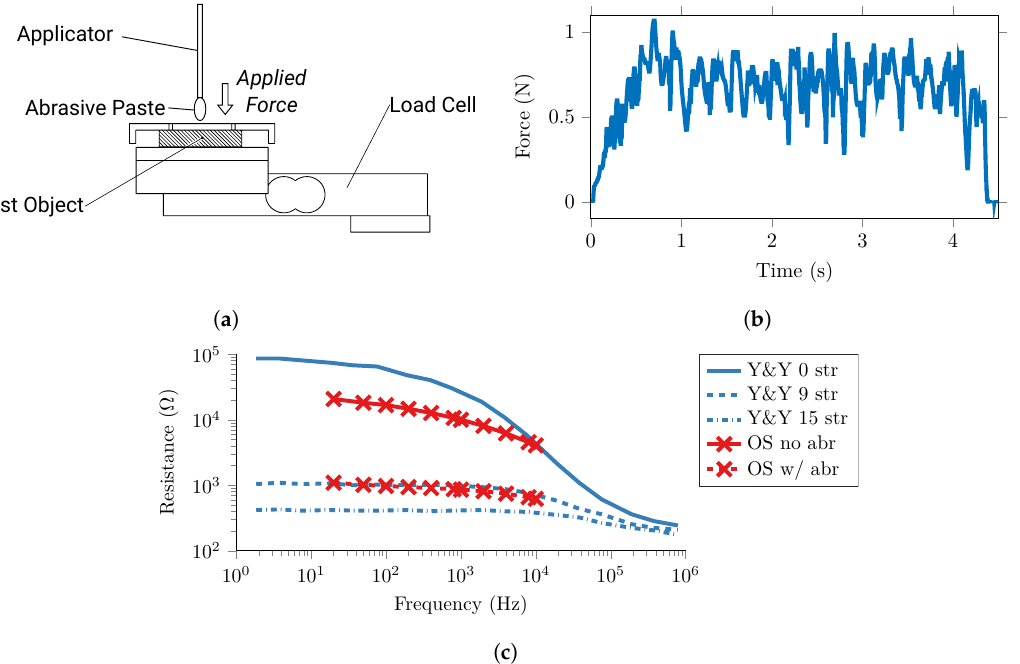
Figure 5. Characterisation of conventional manual abrasion via applicator and abrasive paste ( a ) experimental setup ( b ) typical force profile ( c ) comparison of orange skin (OS) impedance before and after abrasion, and impedance of human skin with 0, 9, and 15 strippings from Yamamoto and Yamamoto [41]